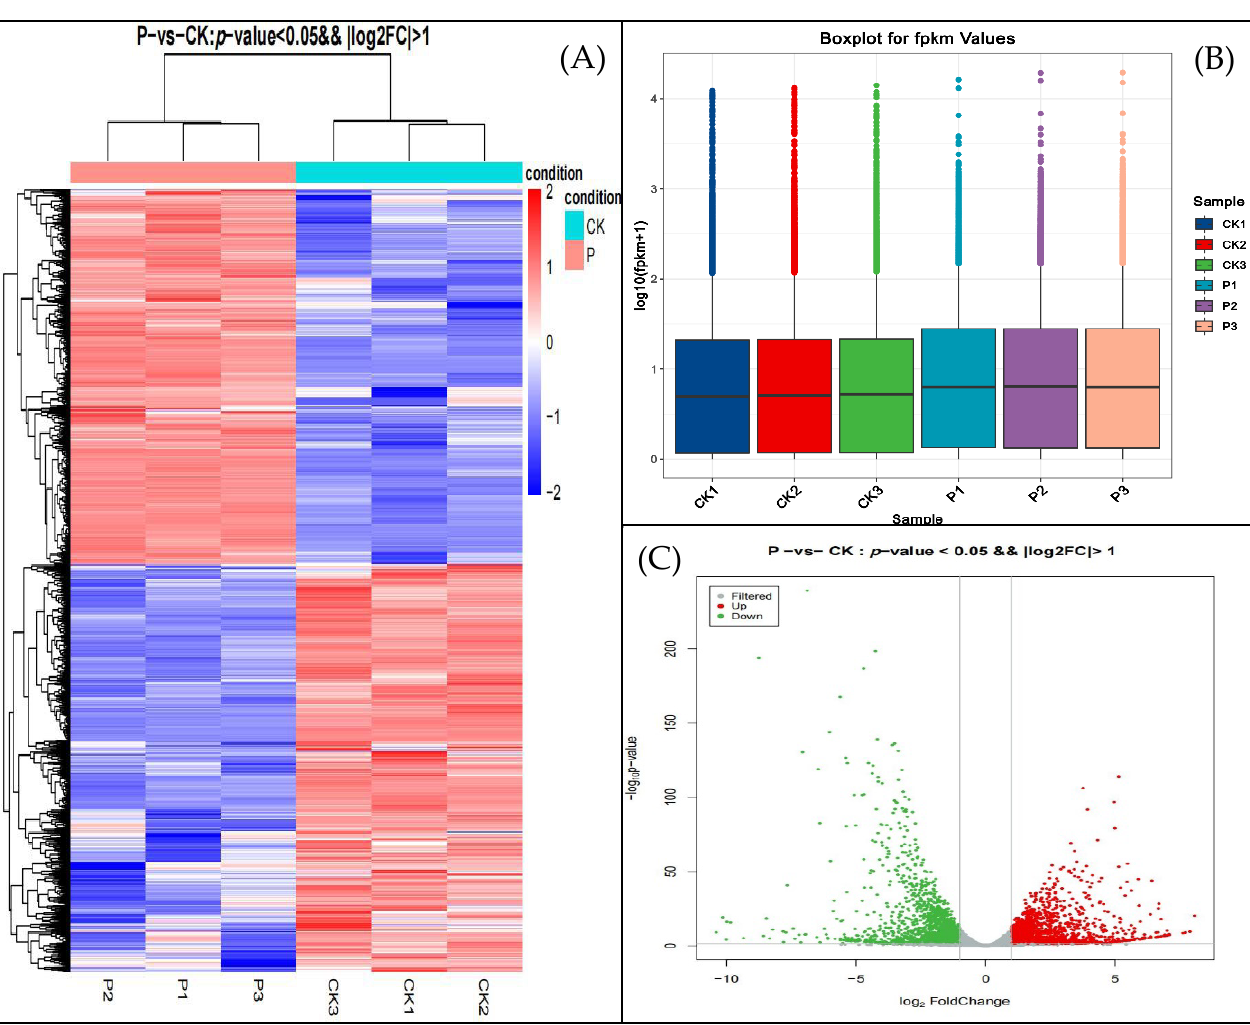
Figure 5. ( A ) Heatmap of DEGs in oat leaves infected by Pga. Red indicates upregulated DEGs and blue indicates downregulated DEGs. DEGs, differentially expressed genes; FC, fold change; CK, no Pga inoculation; P, Pga inoculation. ( B ) The boxplot figure of FPKM in different experimental conditions. The X-axis represents sample names and the Y-axis is log 10 (FPKM) value of different genes. The box plots for each region correspond to five statistics (from top to bottom are maximum, third quartile, median, first quartile, and minimum, respectively). ( C ) Volcano plot of differentially expressed genes between CK and P. The green dots represent downregulated DEGs, the red dots represent upregulated DEGs, and the gray represents detected but not significantly differentially expressed genes.